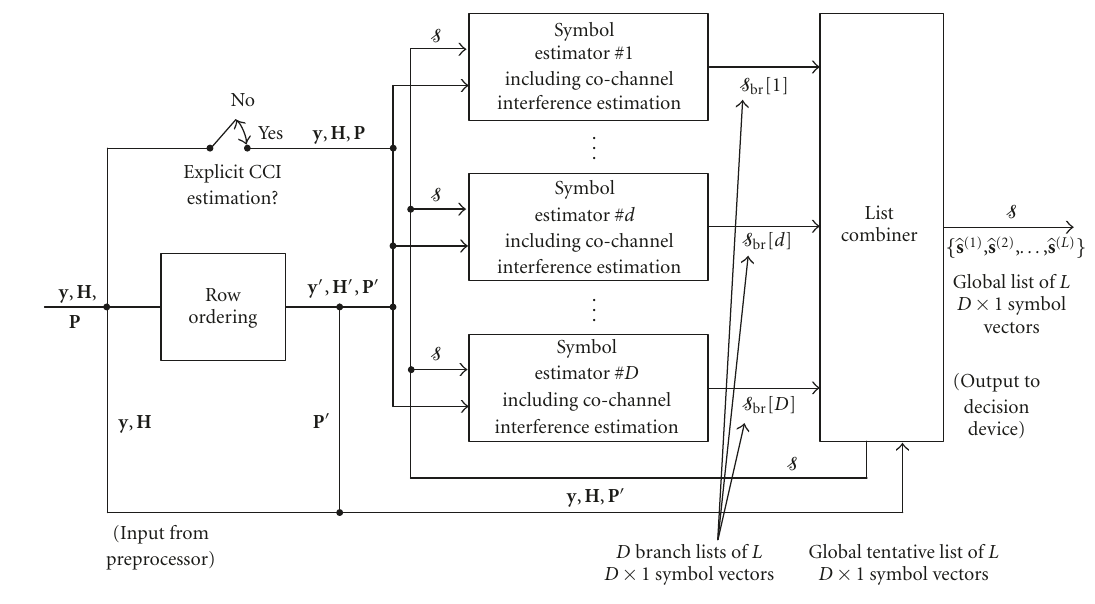
Figure 4: Block diagram of the parallel detector with interference estimation (PD-IE).